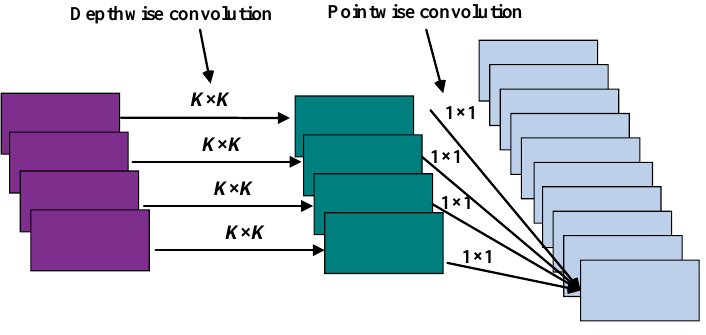
Figure A1. The diagram of DS-Conv.